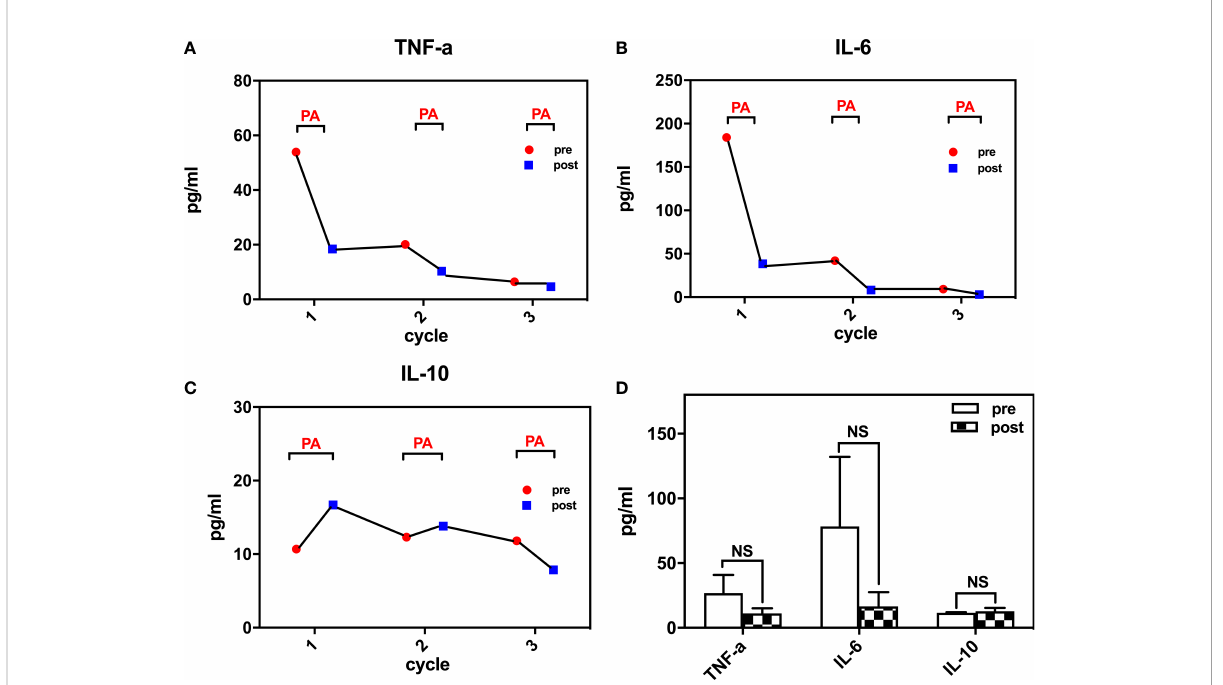
FIGURE 3 In fl ammatory cytokines changes during treatment (A) TNF-a levels during the course; (B) IL-6 levels during the course; (C) IL-10 levels during the course; (D) changes of TNF-a, IL-6, IL-10 pre- and post- plasma adsorption). TNF-a, tumor necrosis factor-a; IL-6, interleukin-6; IL-10, interleukin-10. NS, not signi fi